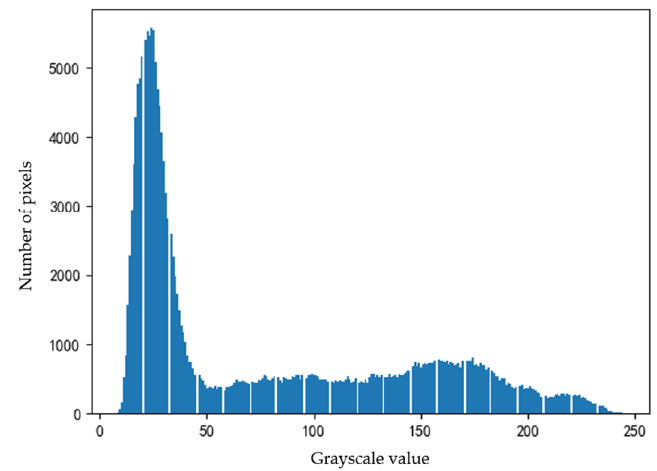
Figure 4. Calculated image histogram.